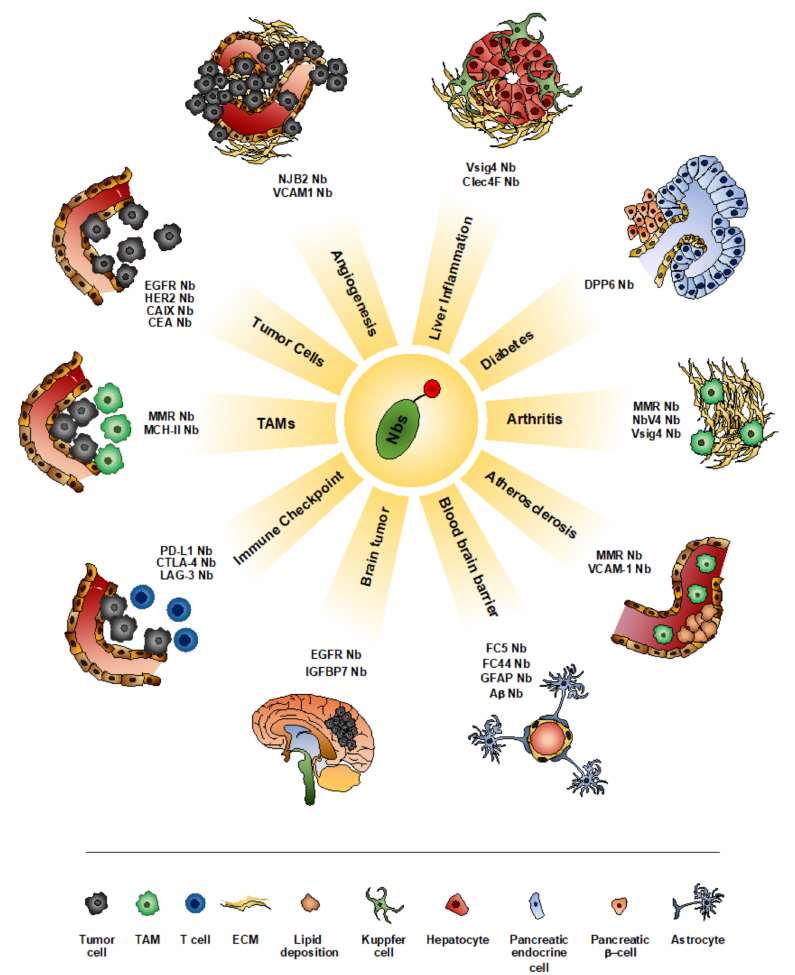
Figure 1. Nanobodies (Nbs) as imaging tool for the visualization of di ff erent pathological conditions. Nbs have been successfully used for the visualization of a variety of pathologies. Di ff erent aspects of neoplastic progression have been evaluated using Nbs targeting tumor cells (EGFR-Nb, HER2-Nb, CAIX-Nb and CEA-Nb), tumor angiogenesis (NJB2-Nb and VCAM-1-Nb), TAM infiltration (MMR-Nb and MHC-II-Nb) or components of immune checkpoints (PD-L1-Nb, CTLA-4-Nb and LAG-3-Nb). Similarly, several inflammatory diseases have been successfully monitored using Nbs, including liver inflammation (Vsig-Nb and ClecF4-Nb), diabetes (DPP6-Nb), rheumatoid arthritis (MMR-Nb, NbV4-Nb and Vsig-Nb) and atherosclerosis (MMR-Nb and VCAM-1-Nb). Moreover, Nbs have been applied for the visualization of brain tumors (EGFR-Nb and IGFBP7-Nb). In addition, due to their small dimension, Nbs more easily cross the blood brain barrier and accumulate into the brain parenchyma (FC5-Nb, FC44-Nb, GFAP-Nb and A β